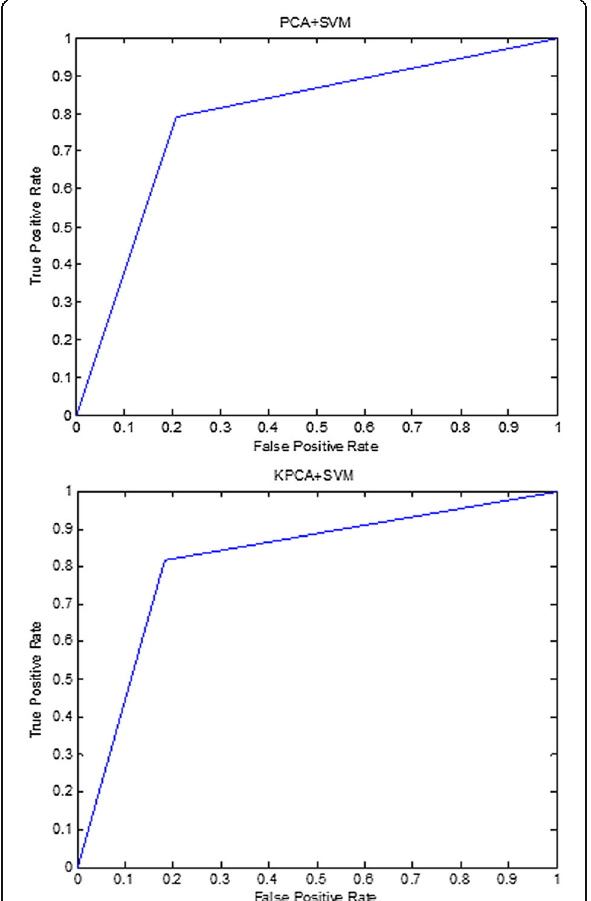
Fig. 5 Receiver operating characteristic (ROC) of through-wall human being detection